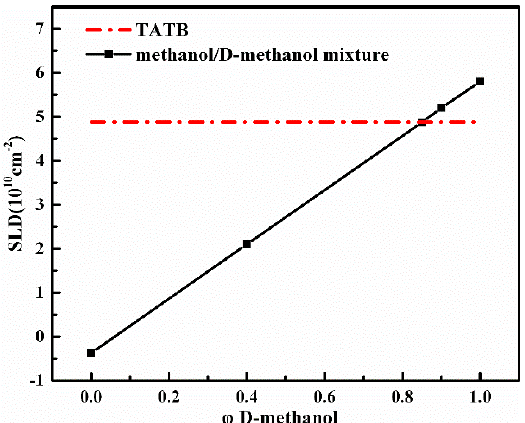
Figure 1. Neutron scattering length density (SLD) of the mixture of methanol and deuterated methanol (solid line) as a function of volume fraction of D-methanol, φ . The experimental conditions are marked by solid squares and the SLD of 1,3,5-triamino-2,4,6-trinitrobenzene (TATB) represent by dash-dotted line.